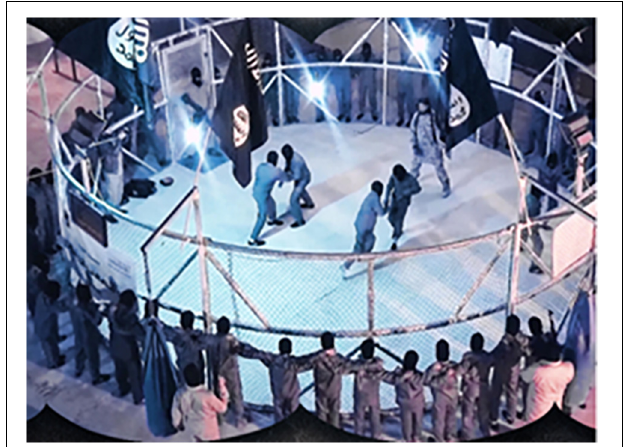
FIGURE 1 | Front page of the PE